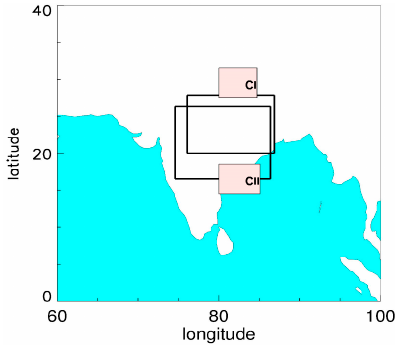
Figure 1. Map of the Indian subcontinent with CI and CII regions marked with appropriate boundaries (also shown in [39]). CI is the region chosen by [5], and CII is the region chosen by [8].